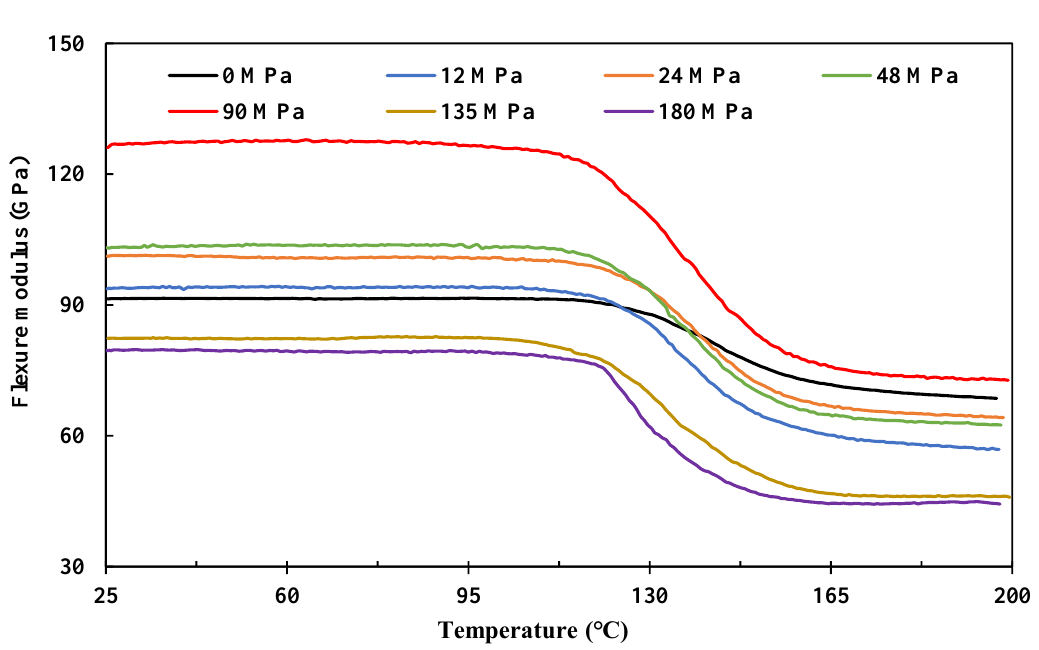
Figure 8. Effects of prestress level on the flexure modulus of the composite determined from three- point bending under temperature sweep from 25 °C~200 °C.